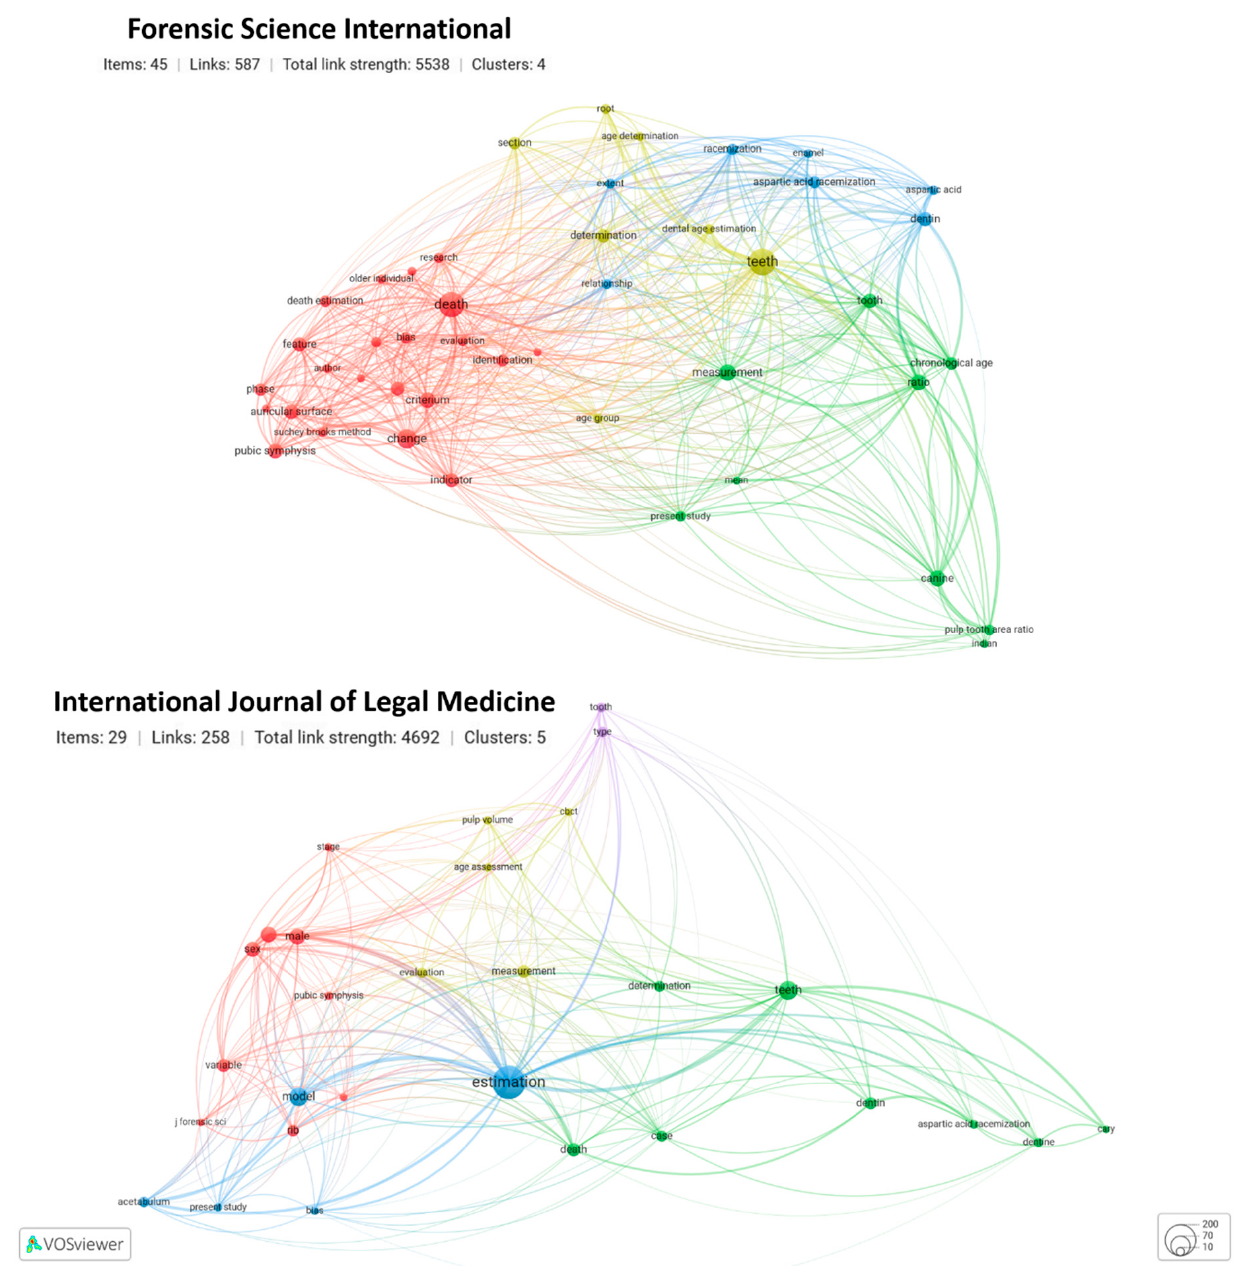
Figure 12. Network visualization for the co-occurrence of terms for Forensic Science International and International Journal of Legal Medicine and the American Journal of Biological Anthropology of the TOP4 journals. The interactable maps are accessible at: Forensic Science International https://app.vosviewer.com/?json=https://drive.google.com/uc?id=1Hax3Qkt7os5JqKl61TEeYRrDzW7Sk4hS; International Journal of Legal Medicine https://app.vosviewer.com/?json=https://drive.google.com/uc?id=1KOSNyp6sb6y18c18n_IPaRoQEfU- jHQ-R (Accessed on 16 January 2023).